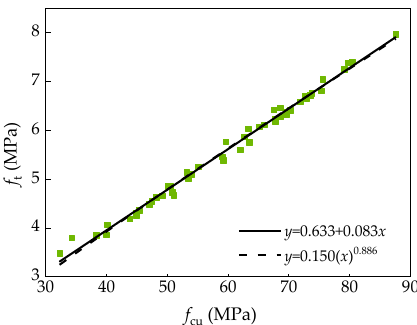
Figure 7. Relationship between compressive strength and splitting strength.